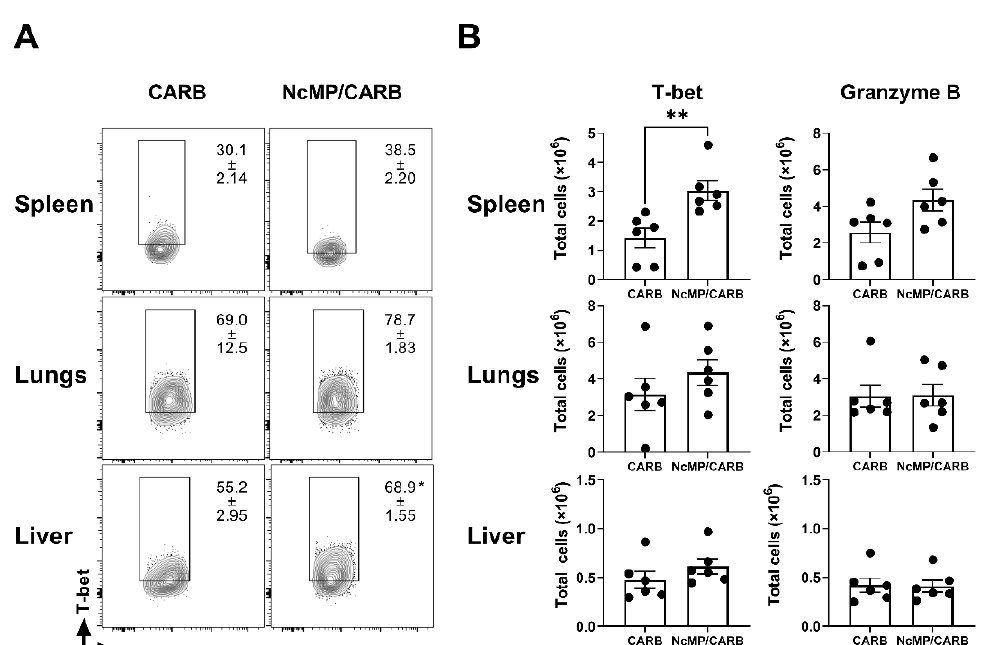
Figure 9. Expression of T-bet and granzyme B in CD8 + T cells of infected mice. ( A ) Representative contour plot analysis of CD8 + CD44 + T cells expressing T-bet in the indicated organs of sham- immunized (CARB) or immunized (NcMp/CARB) mice, as indicated, 7 days after i.p. challenged with 1 × 10 7 N. caninum tachyzoites. Numbers within contour plots correspond to mean percentage values ± SEM of T-bet expressing cells within the CD8 + CD44 + T cell population. ( B ) Numbers of CD8 + CD44 + T-bet + and CD8 + CD44 + granzyme B+ cells in the indicated organs of immunized and sham-immunized mice. Each symbol (black circle) represents an individual mouse. Results are representative of two independent experiments that yielded concordant results ( n = 6 group; * p < 0.05; ** p < 0.01, unpaired t -test).